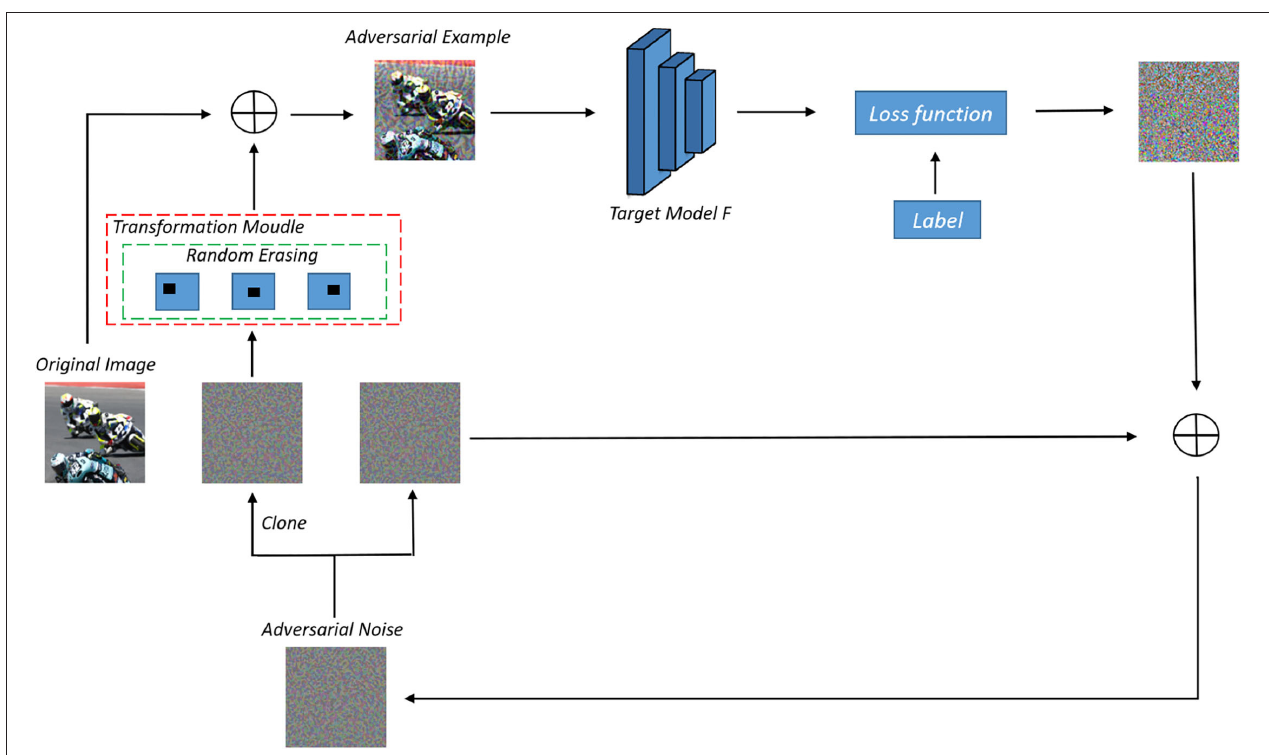
FIGURE 3 | The framework of our